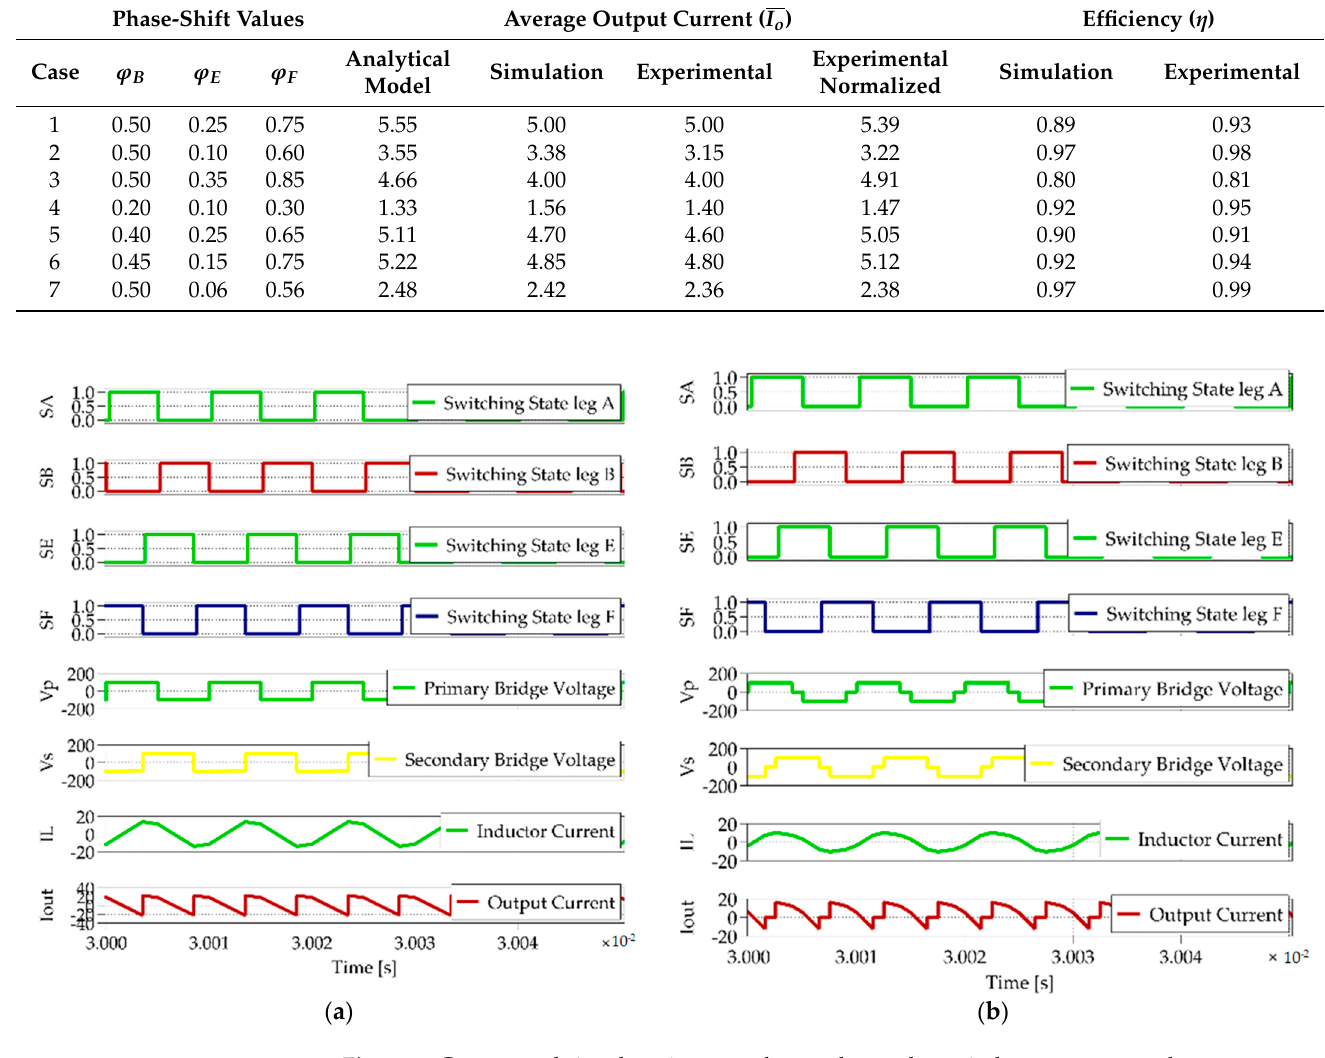
Figure 9. Gate control signals, primary and secondary voltage, inductor current and output current (PLECS simulation): ( a ) Case 3; ( b ) Case 5.